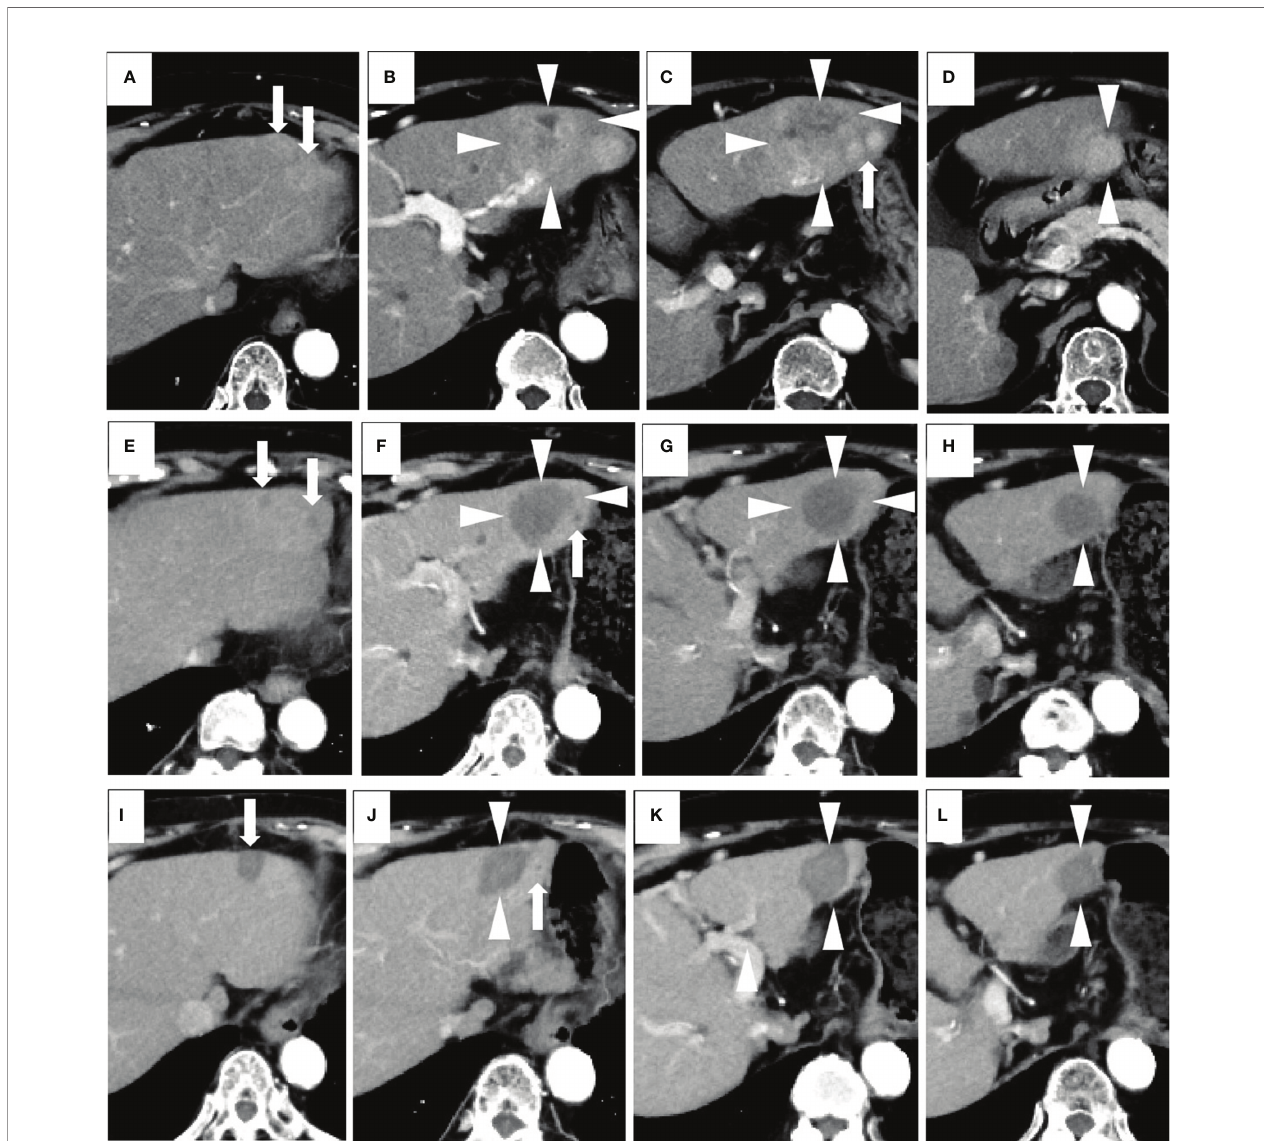
FIGURE 2 | A case of combined lenvatinib and radiofrequency ablation (RFA) therapy. The patient was an 80-year-old female with no history of viral hepatitis. Her up-to-seven score was 9.3, and her Child-Pugh score was A5. All of these images were taken via arterial phase of contrast-enhanced CT (CECT). Images (A – D) were taken prior to the start of lenvatinib therapy. The target lesions were a larger one (a maximum diameter of 53 mm) (arrowheads) and a surrounding smaller one (arrows) located in the left lobe of the liver. Both of the tumors appeared as high-density areas. Images in (E – H) were taken 2 months after the administration of the recommended dose of lenvatinib. A marked decrease in the vascularity and size of each lesion were revealed. No newly developed lesions were observed. Therefore, this patient was evaluated as having a partial response according to the modi fi ed Response Evaluation Criteria in Solid Tumors (mRECIST). The maximum diameter of the main tumor decreased from 53 to 38 mm (arrowheads). One month after RFA, none of the lesions had any vascularity, and no new lesions were detected. Therefore, this patient was evaluated as having a complete response according to the mRECIST (image not shown). Images in (I – L) were taken 7 months after RFA (corresponding to 10 months from the start of lenvatinib), and all HCC lesions appeared as non-enhanced areas and showed a continual and marked decrease in size. Therefore, a complete response was recorded. For this patient, the initial tumor response was partial response (PR), while the best tumor response was complete response